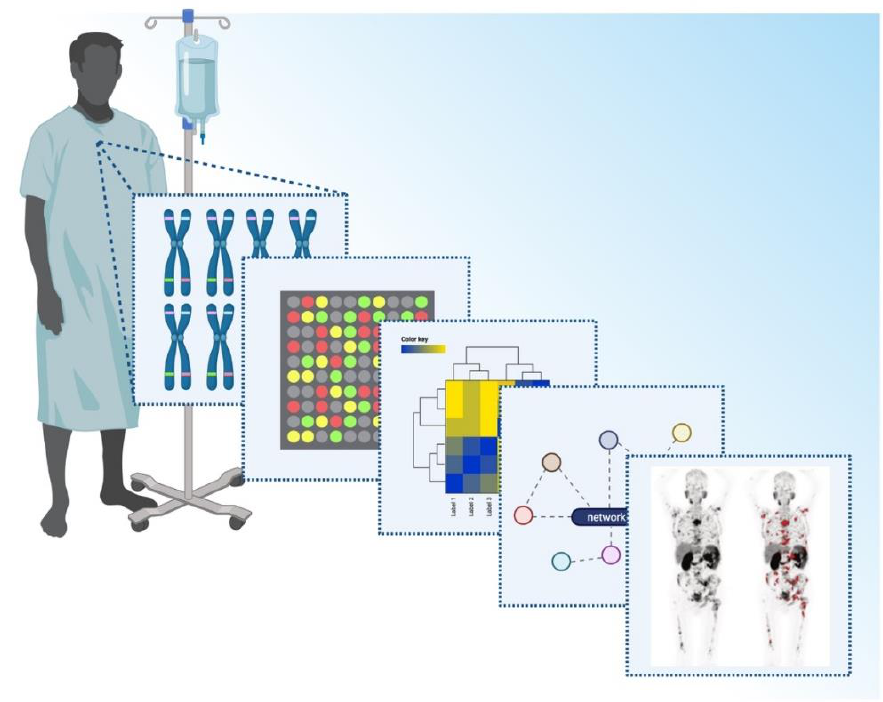
Figure 2. Precision medicine-mediated patient profiling for mCRPC management. Besides routine diagnostics, multiple screenings should be included in the diagnostic process. Genomic analysis for mutation status such as BRCA1/2, PTEN, AR and others should be combined with gene expression analysis and subsequent analysis of interactions and networks. 68 Ga-PSMA-PET/CT is an indis- pensable component of this screening process and allows detection of tumor distribution and load. mCRPC: metastatic castration-resistant prostate cancer; BRCA1/2: breast cancer 1/2 gene; PTEN: phosphatase and tensin homolog on chromosome ten; AR: androgen receptor; 68Ga: 68Gallium; PSMA: prostate-specific membrane antigen; PET/CT: positron-emission tomography/computer to- mography. This figure was generated using biorender, www.biorender.com, accessed on 8 July 2021.